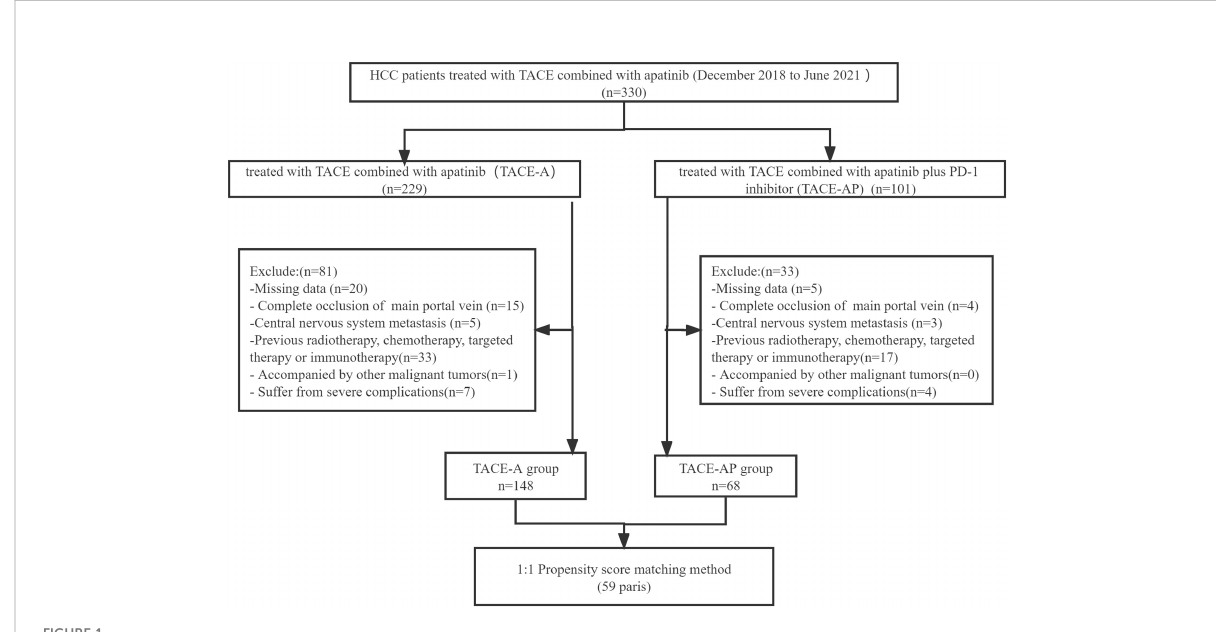
FIGURE 1 Flow diagram of patient